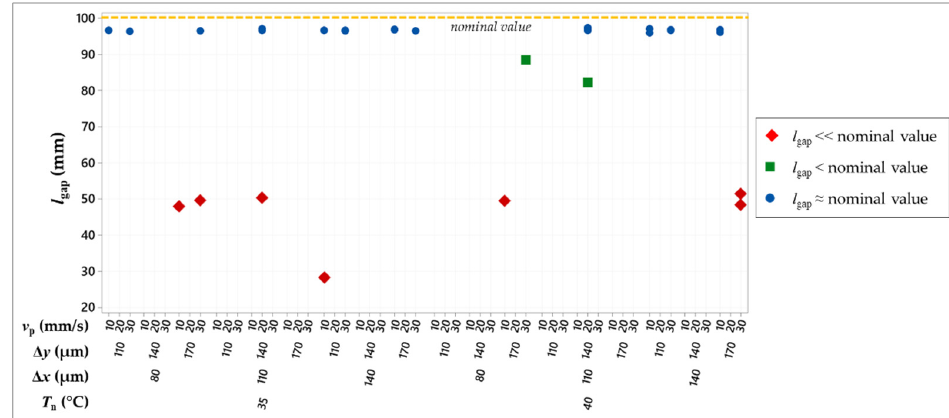
Figure 11. Individual value plot of gap length.